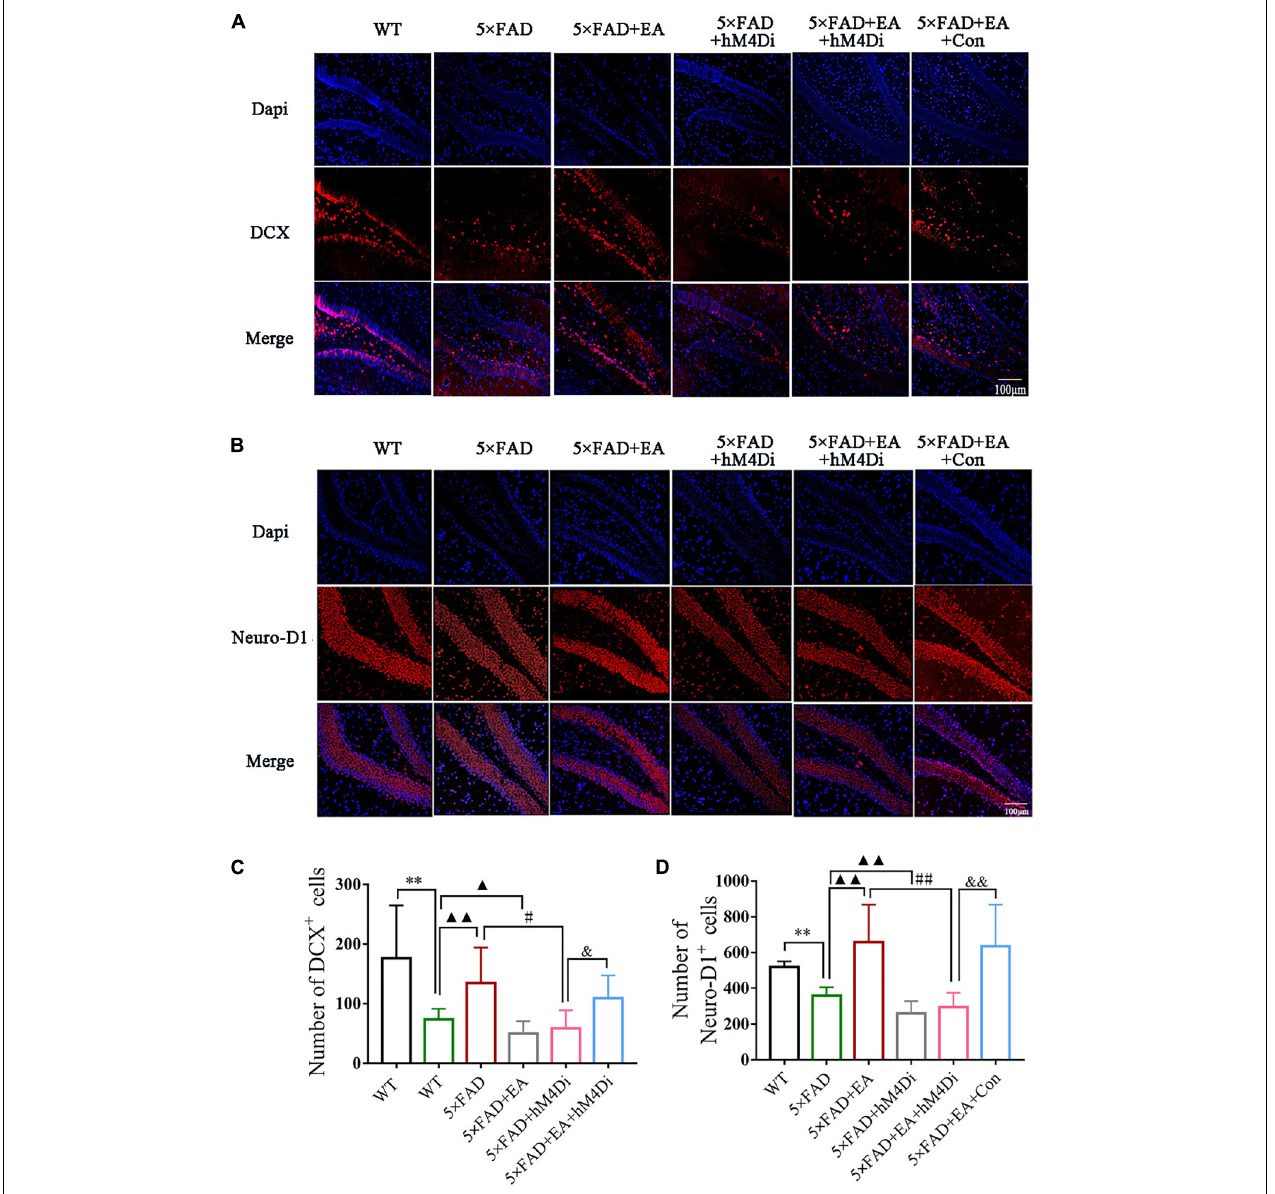
FIGURE 13 | EA treatment activates the MS/VDB-DG cholinergic neural circuit promoting hippocampus neurogenesis in 5 × FAD mice. Representative images of doublecortin (DCX) (A) and Neuro-D1 (B) in the DG. Groups were subjected to immunofluorescence labeling with Dapi (Blue), DCX or Neuro-D1 (red) staining. Scale bar = 100 µ m. Quantified DCX positive cells (C) and Neuro-D1 positive cells (D) . Data are represented as mean ± SD, n = 4/group ( ∗∗ p < 0.01 vs WT group; (cid:78) p < 0.05 and (cid:78)(cid:78) p < 0.01 vs 5 × FAD group; # p < 0.05 and ## p < 0.01 vs 5 × FAD + EA group; & p < 0.05 and && p < 0.01 vs 5 × FAD + EA + hM4Di group). DCX, doublecortin; Neuro-D1, neurogenic differentiation factor